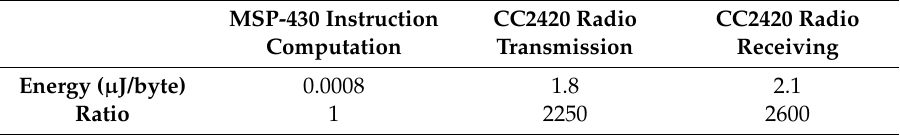
Table 2. The computation cost and communication cost per byte